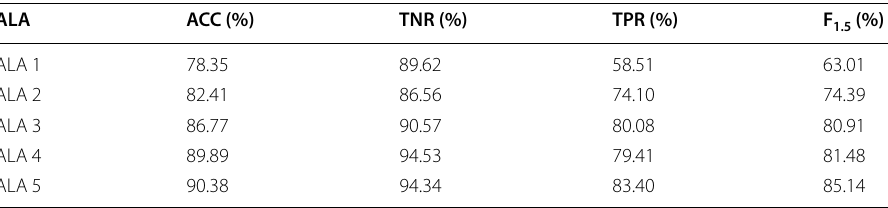
Table 3 Accuracy of the GAR model for Markets and behavior course ALA ACC